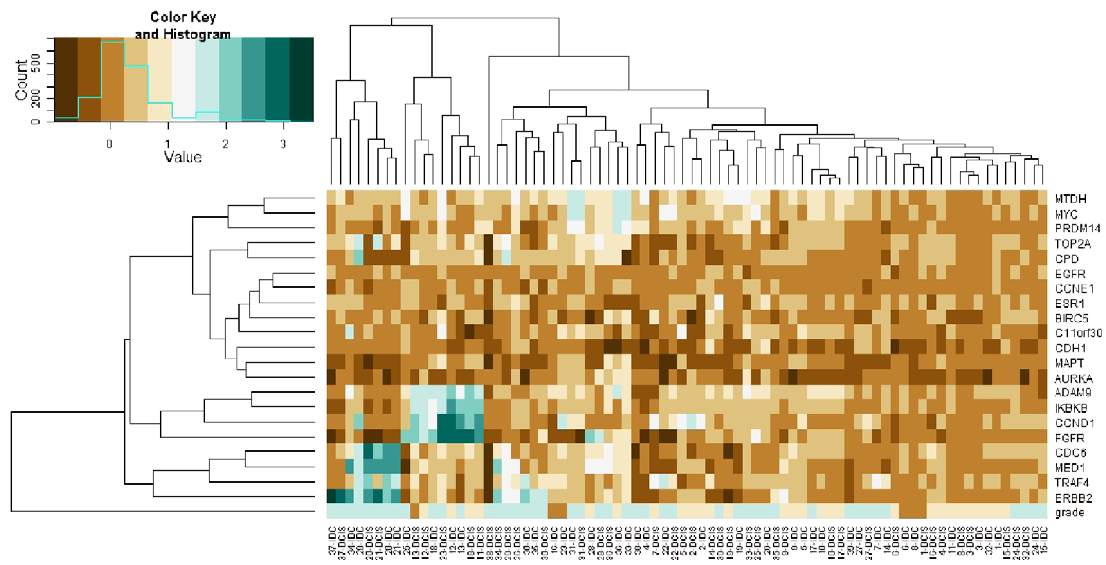
Fig. 3. Cluster analysis of 21 genes in low/intermediate and high-grade DCIS and adjacent IDC (Grade: dark brown: grade 1, light brown: grade 2, blue: grade 3). (The colors are visible in the online version of the article;